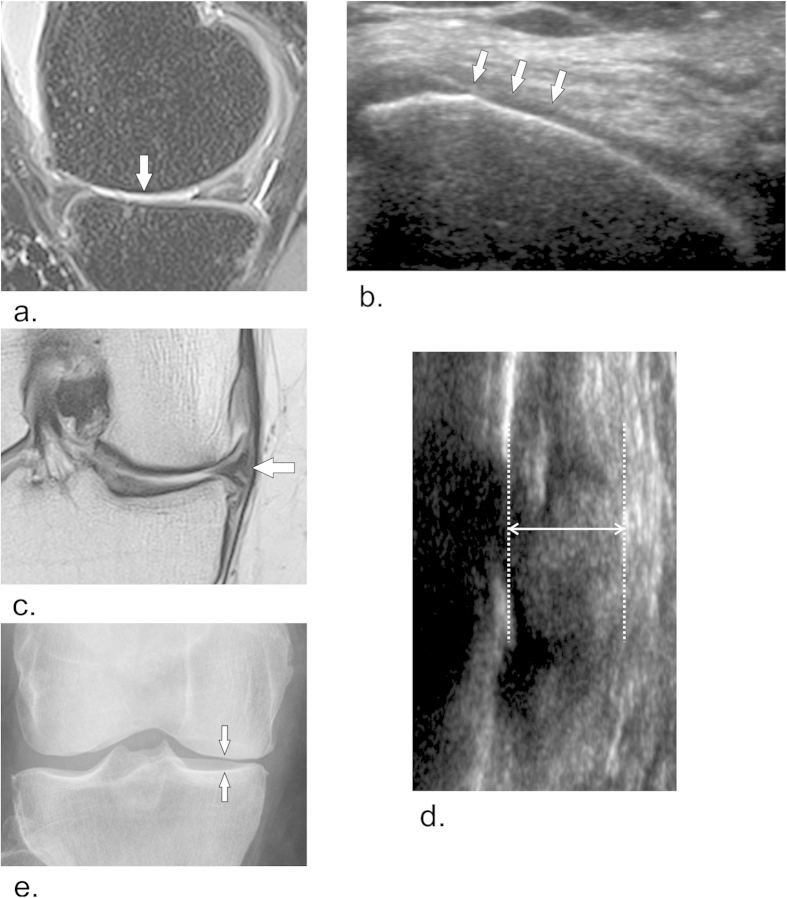
Example of structural cartilage changes and meniscal extrusion as seen in magnetic resonance images (MRI), ultrasound images and radiograph of 57-year-old symptomatic woman.Medial femoral condyle cartilage thinning indicated by white arrows in sagittal proton density weighted fat-suppressed MRI (a) and ultrasound transversal B-mode image (b). Medial meniscal extrusion can be observed in coronal proton density weighted MRI (c) (white arrow) and longitudinal B-mode ultrasound image (d) (double headed arrow). Anterior-posterior radiograph (e) demonstrates medial joint space narrowing (white arrows) as a surrogate of meniscal and cartilage structural changes.